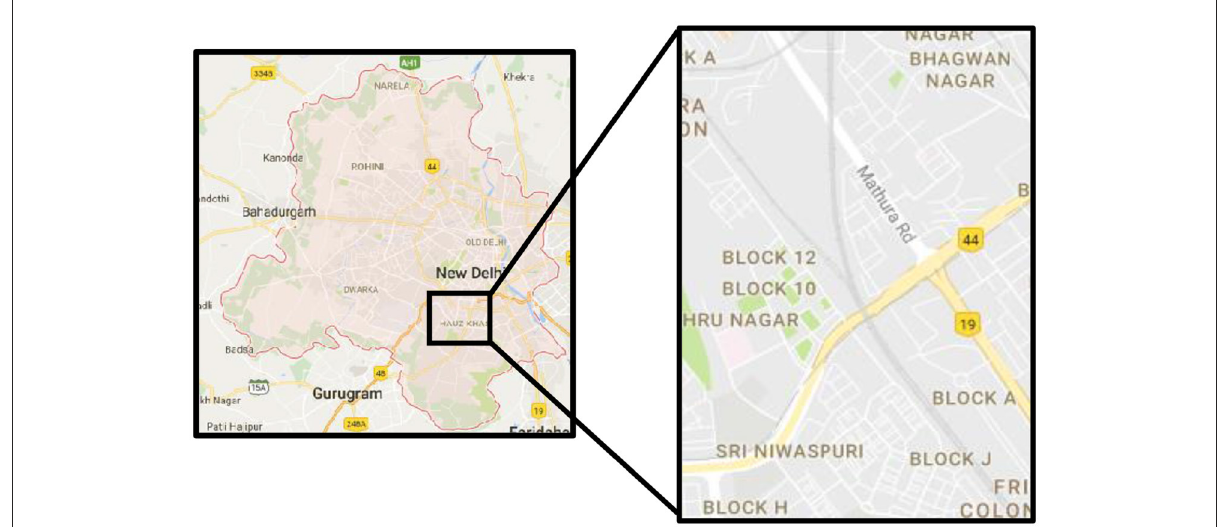
FIGURE1 Geographical locations of New Delhi and residential area (Source: G https://www.google.com/maps/place/Ashram$+$chowk/@28.5753643,77. 2511544,17z/data$=$!3m1!4b1!4m5!3m4!1s0x390ce37ac7564bdd:0x9fe5bff9a0eb95df!8m2!3d28.5753601!4d77.2556314).